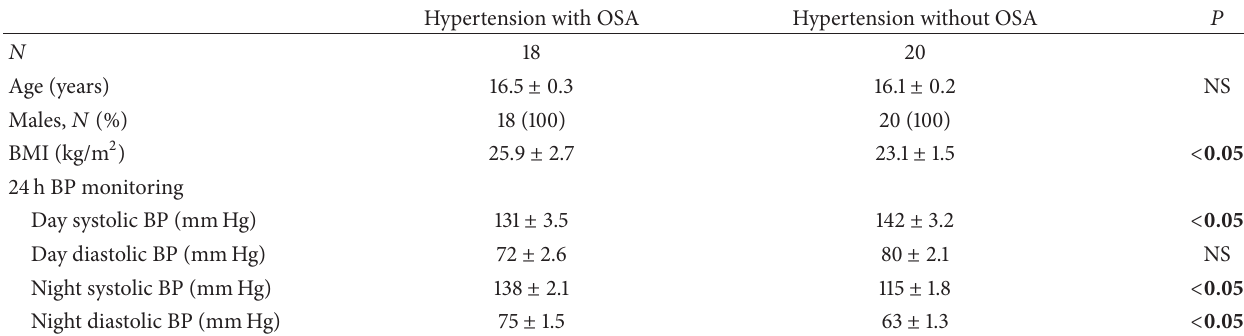
Table 1: Participant demographic and blood pressure characteristics in hypertensive adolescents with and without OSA.